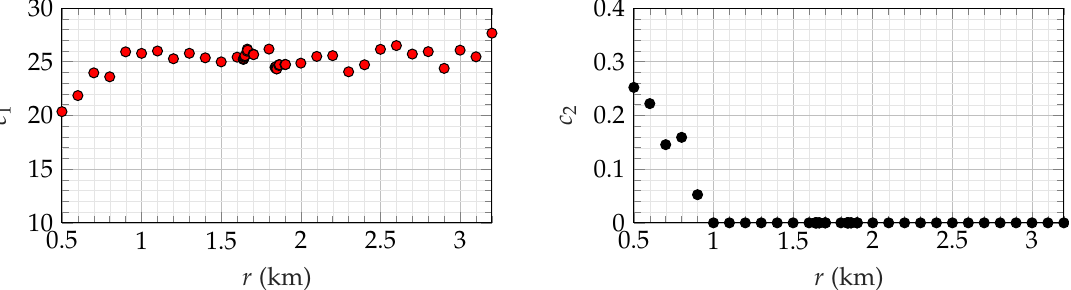
Figure 14. Coefficients of the two-parameter wind coherence function fitted to the wind coherence measured from 18 May 2016 to 21 June 2016 using LE only (E-W configuration), with 10 m s − 1 14 m s − 1 and 0.5km 3.2km. v r r · ≤ | · ≤ ≤ | ≤